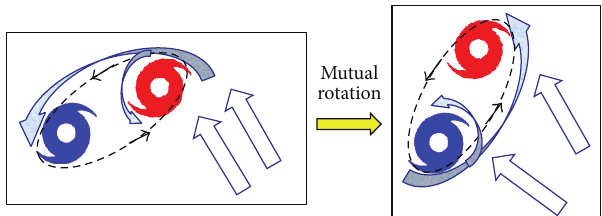
Figure 13: Schematic diagram portraying the TC mutual rotation and binary TC interaction process. The thick arrows donate the moisture flux source; the solid blue arrows donate the moisture flux channel; the dashed arrows illustrate the cyclonic